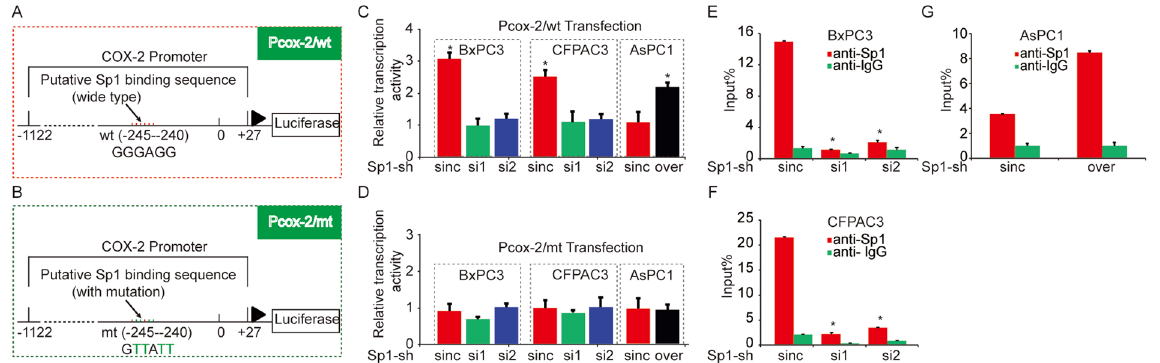
Figure 3. Sp1 transcriptionally activates COX-2 expression in PDAC cells. ( A ) Schematic diagram of luciferase reporter constructs with the wild-type COX-2 promoter sequence (Pcox-2/wt). ( B ) Schematic diagram of luciferase reporter constructs with the mutant COX-2 promoter sequence (Pcox-2/wt). The COX-2 promoter sequence was between positions − 1122 and + 27 from the transcriptional start site. ( C ) Luciferase activity of pCOX2/wt in PDAC cells. ( D ) Luciferase activity of Pcox-2/mt in PDAC cells. ( E,F ) ChIP assay conducted on Sp1 knockout and/or overexpression cells that also transfected with Pcox-2/wt using a specific anti-Sp1